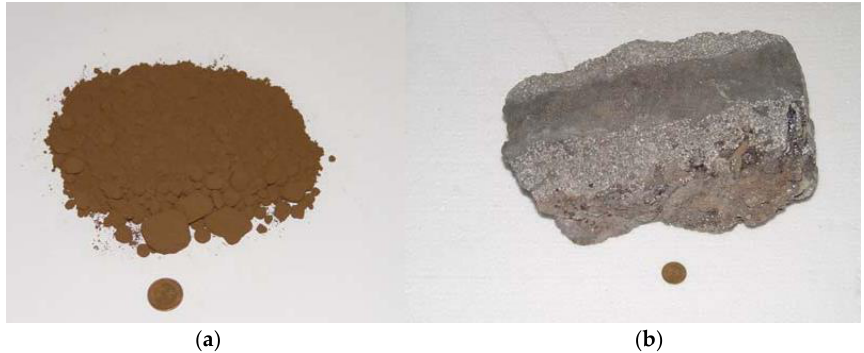
Figure 1. Exterior of the dust before ( a ) and after ( b ) ISV